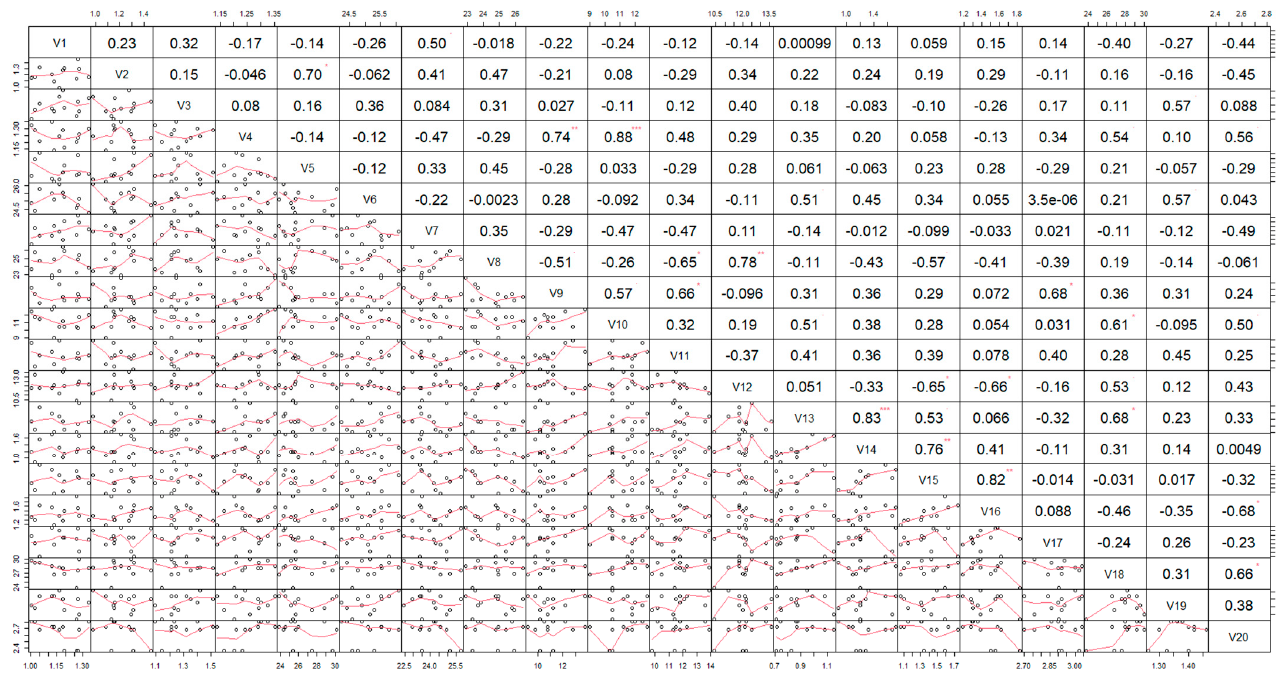
Figure 6. Pearson correlation among soil physical properties, plant characters, and yield. Note: V1, V2, V3, and V4 are, respectively, mean soil bulk density in 5 cm, 15 cm, 25 cm, and 35 cm soil; V5, V6, V7, and V8 are mean moisture content in 5 cm, 15 cm, 25 cm, and 35 cm soil; V9, V10, V11, V12 are, respectively, mean temperature in 5 cm, 15 cm, 25 cm, and 35 cm soil; V13, V14, V15, and V16 are mean SPR in 5 cm, 15 cm, 25 cm, and 35 cm soil; V17 are mean corn plant height; V18 is mean plant stem diameter; V19 is mean spike height; V20 is mean corn yield. *, ** and *** indicate significant correlations at 0.10, 0.05, and 0.01 probability, respectively. Plant stem diameter and yield of corn are strongly correlated and positively corre- lated. SPR in 35 cm soil is negatively correlated with corn yield. The soil temperature in 5 cm soil is strongly correlated with corn plant height, and the soil temperature in 15 cm